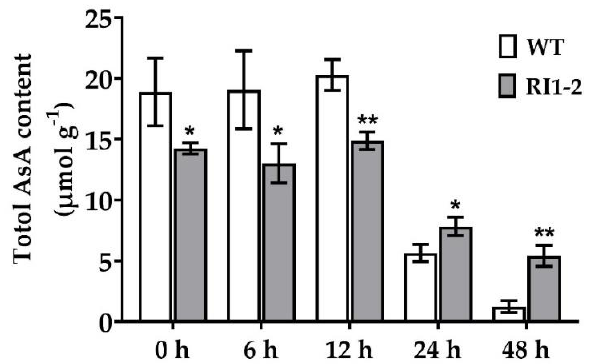
Figure 4. Ascorbic acid content in wild-type (WT) and OsVTC1-1 RI1-2 line after rice fungus inocu- lation with 10100 isolate at 0, 6, 12, 24, and 48 h. Data are presented as the mean ± standard error of three replicates. Asterisk indicates statistically significant differences from WT at each time point analyzed using Student’s t -test (* p < 0.05, ** p < 0.01).